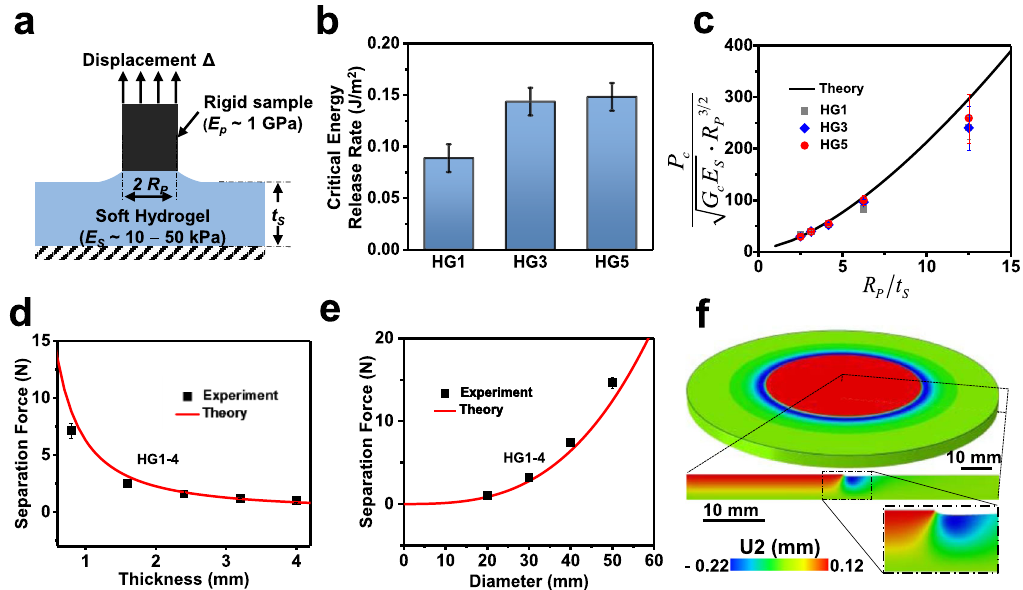
Fig. 4 Mechanics modeling and analysis of the printing process equipped with a hydrogel interface. a Illustration of the mechanic model. b The critical energy release rate for hydrogel/HDDA sample interface. c Comparison of the predicted and measured separation forces under different hydrogel thicknesses and compositions. d Comparison of the predicted and measured separation forces under various hydrogel thickness. e Comparison of the predicted and measured separation forces under various sample diameters. f FEA results of the typical deformed shape and vertical displacement distribution of the hydrogel layer (HG1-4, sample diameter: 50 mm). P c is the separation force, G c is the critical energy release rate of the punch/hydrogel interface, R P is the radius of the punch, E s and t s are the elastic modulus and thickness of the hydrogel, E p is the elastic modulus of the cured part. Error bars: Standard Deviation ( n =